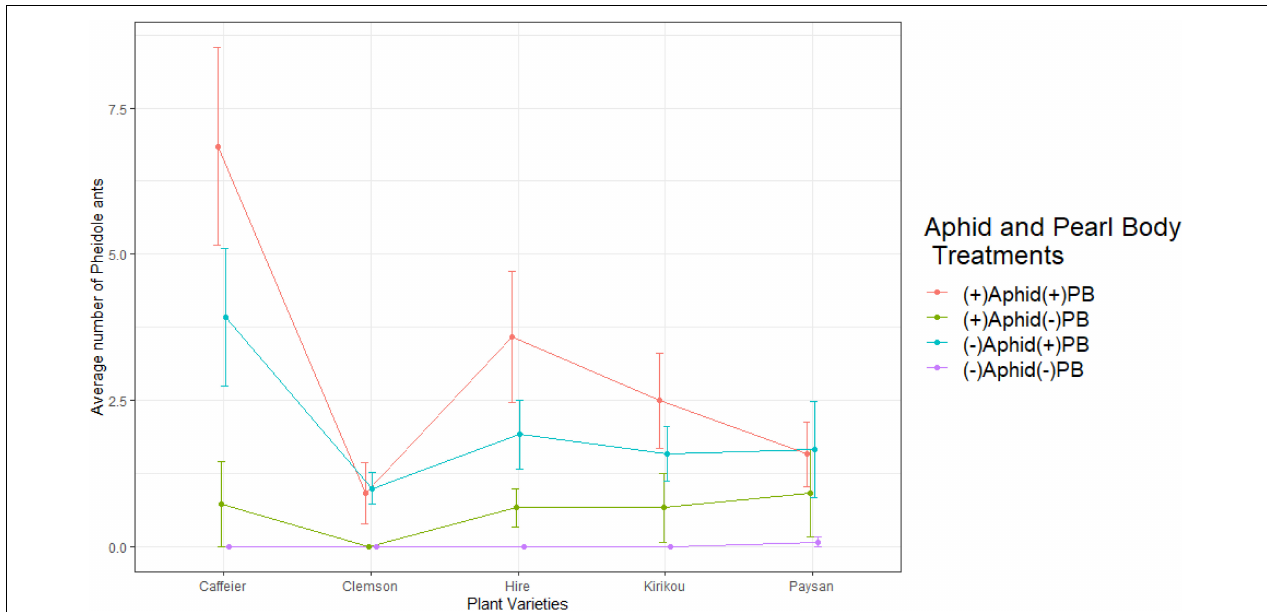
FIGURE 2 | Variation in number of Pheidole ants across plant varieties, in different aphid and pearl body treatments. Pearl bodies were artificially removed for (–)PB plants. Error bars represent ± 1 SE.